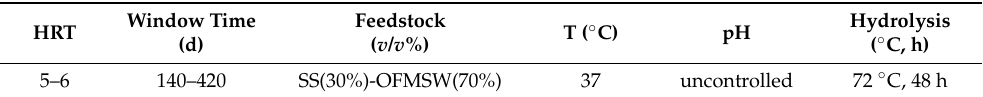
Table 2. Fermenter operating parameters.